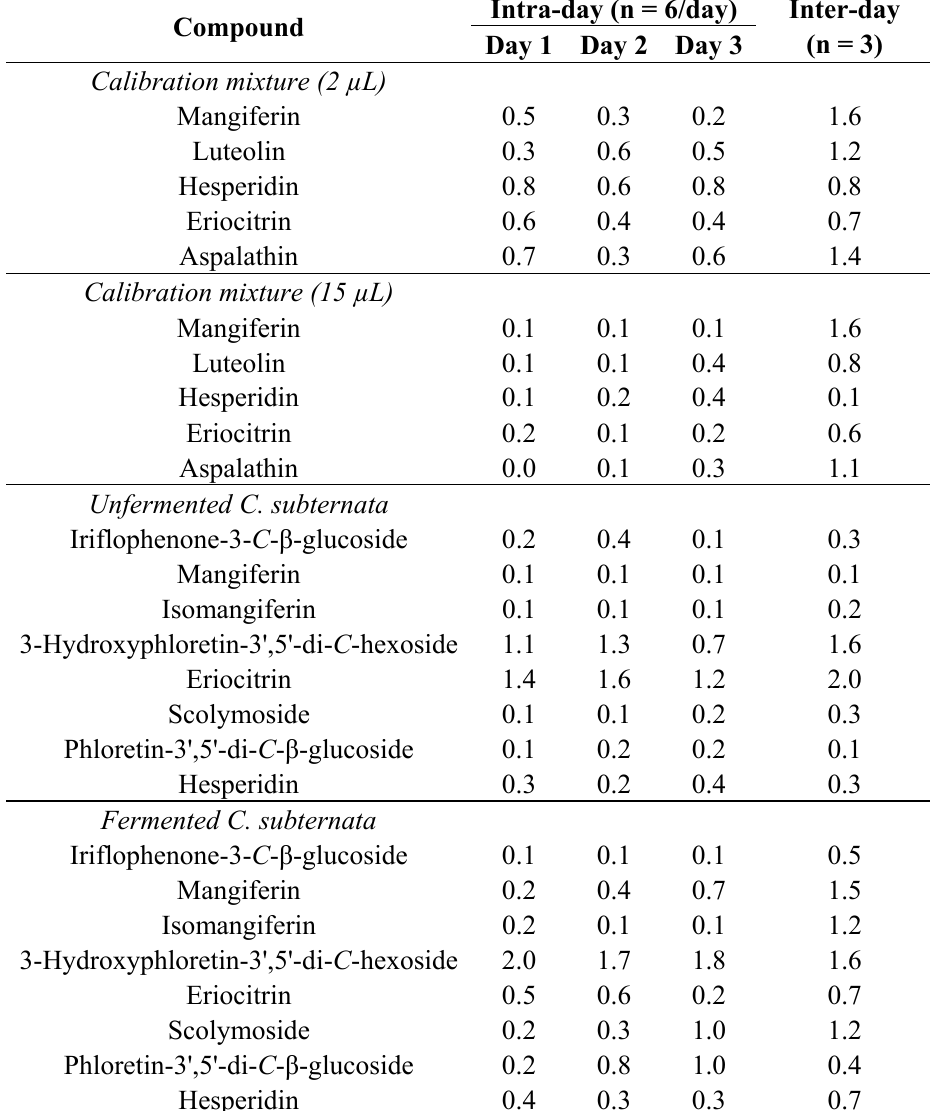
Table 5. Intra- and inter-day precision (%relative standard deviation) for individual phenolic compounds as determined using standard calibration mixtures, as well as freeze- dried aqueous extracts of green and fermented C. subternata